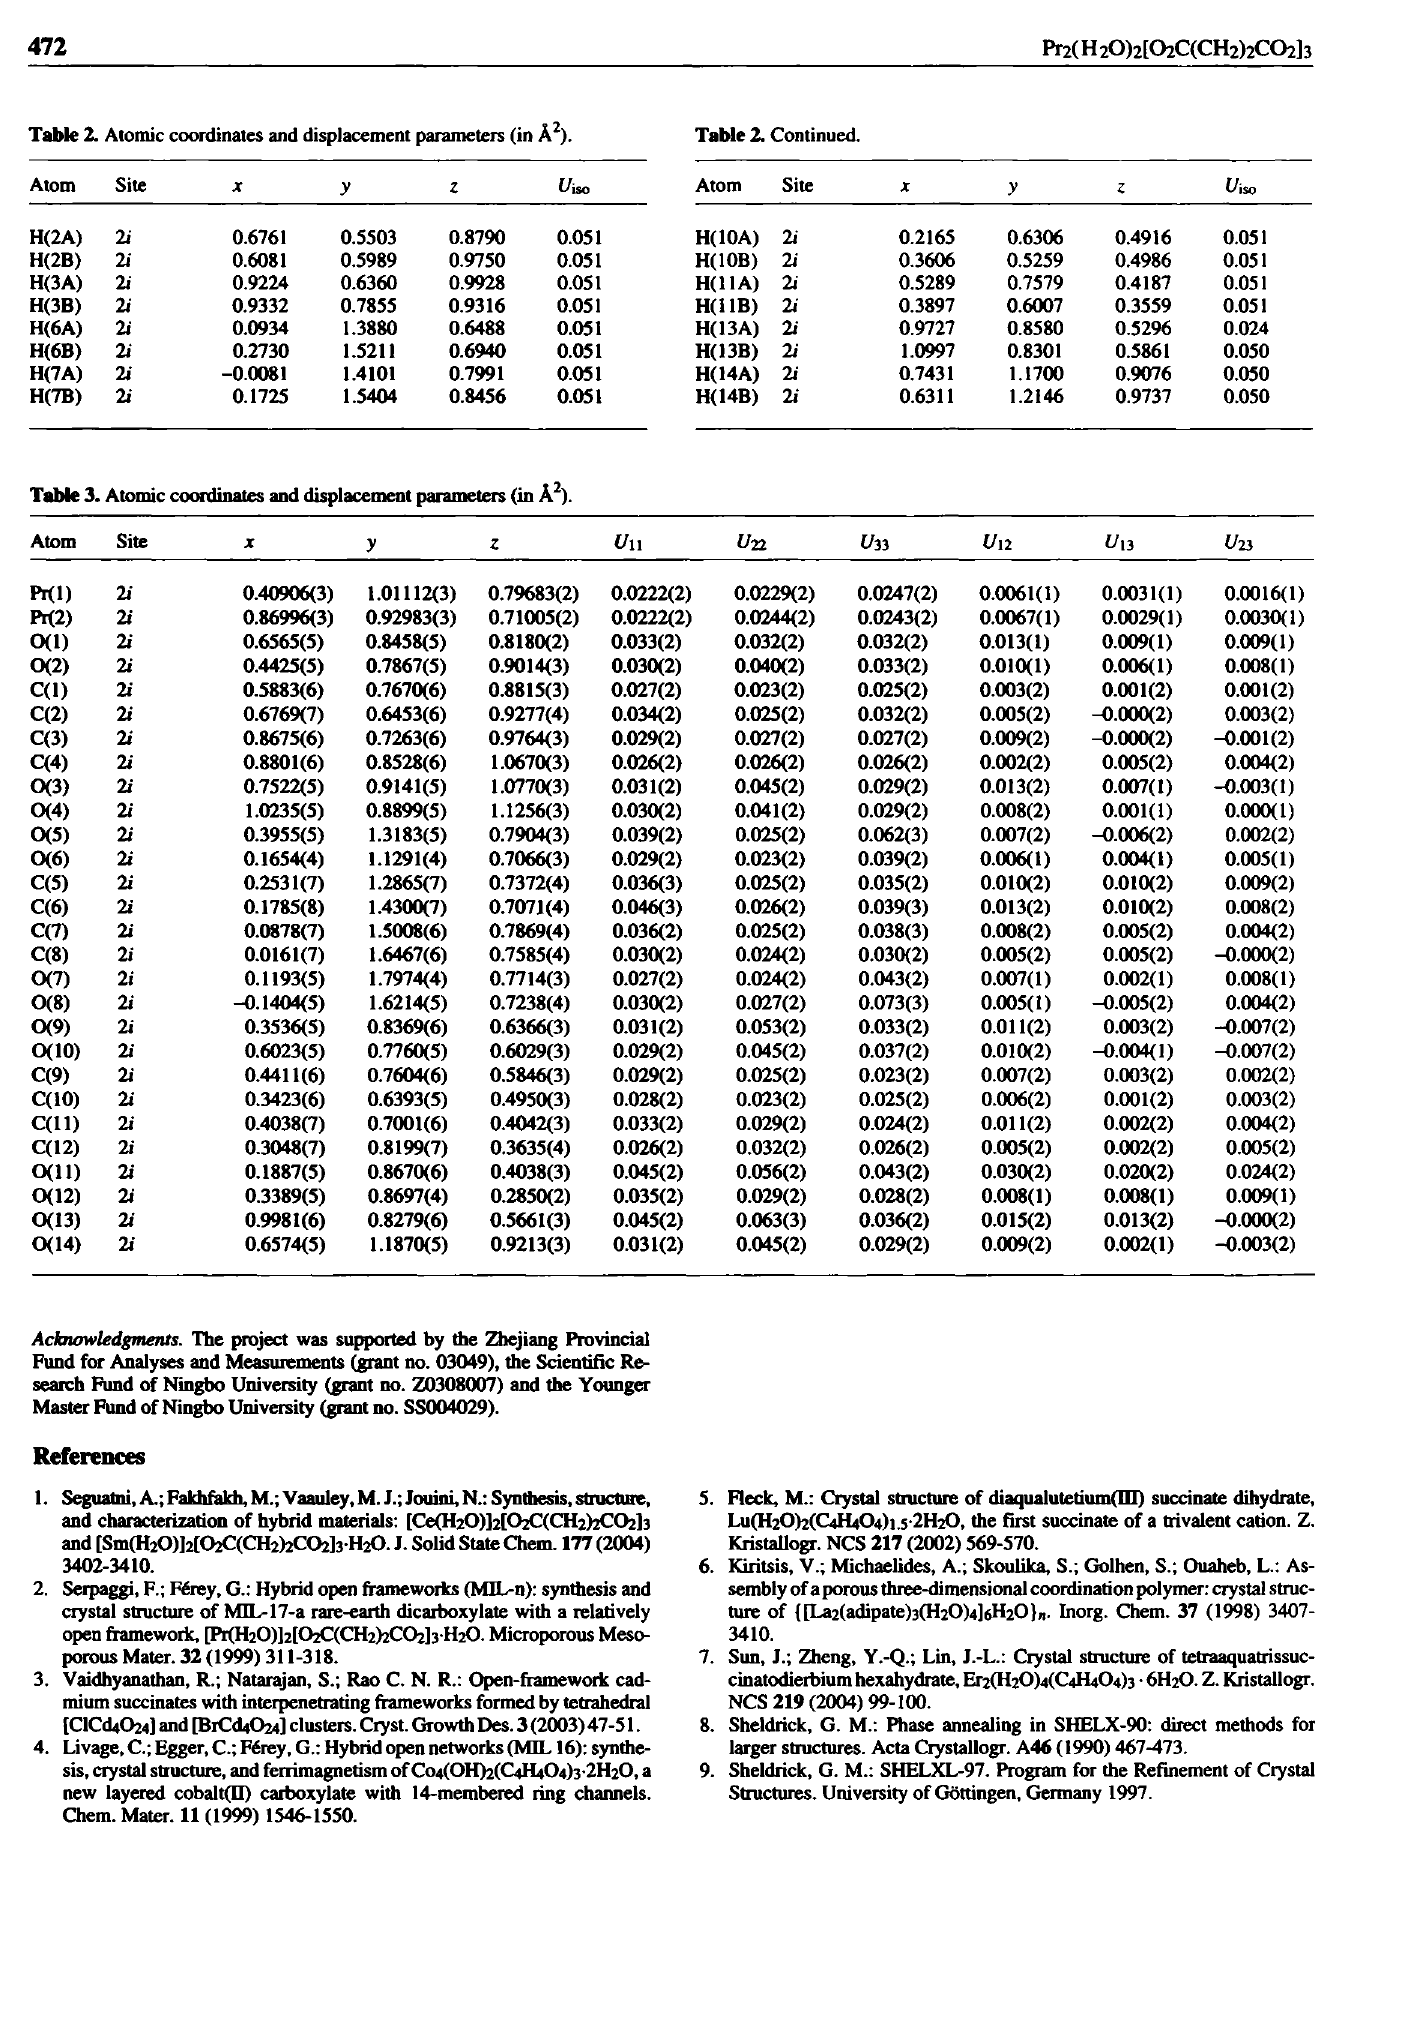
Table 3. Atomic coordinates and displacement parameters (in A 2